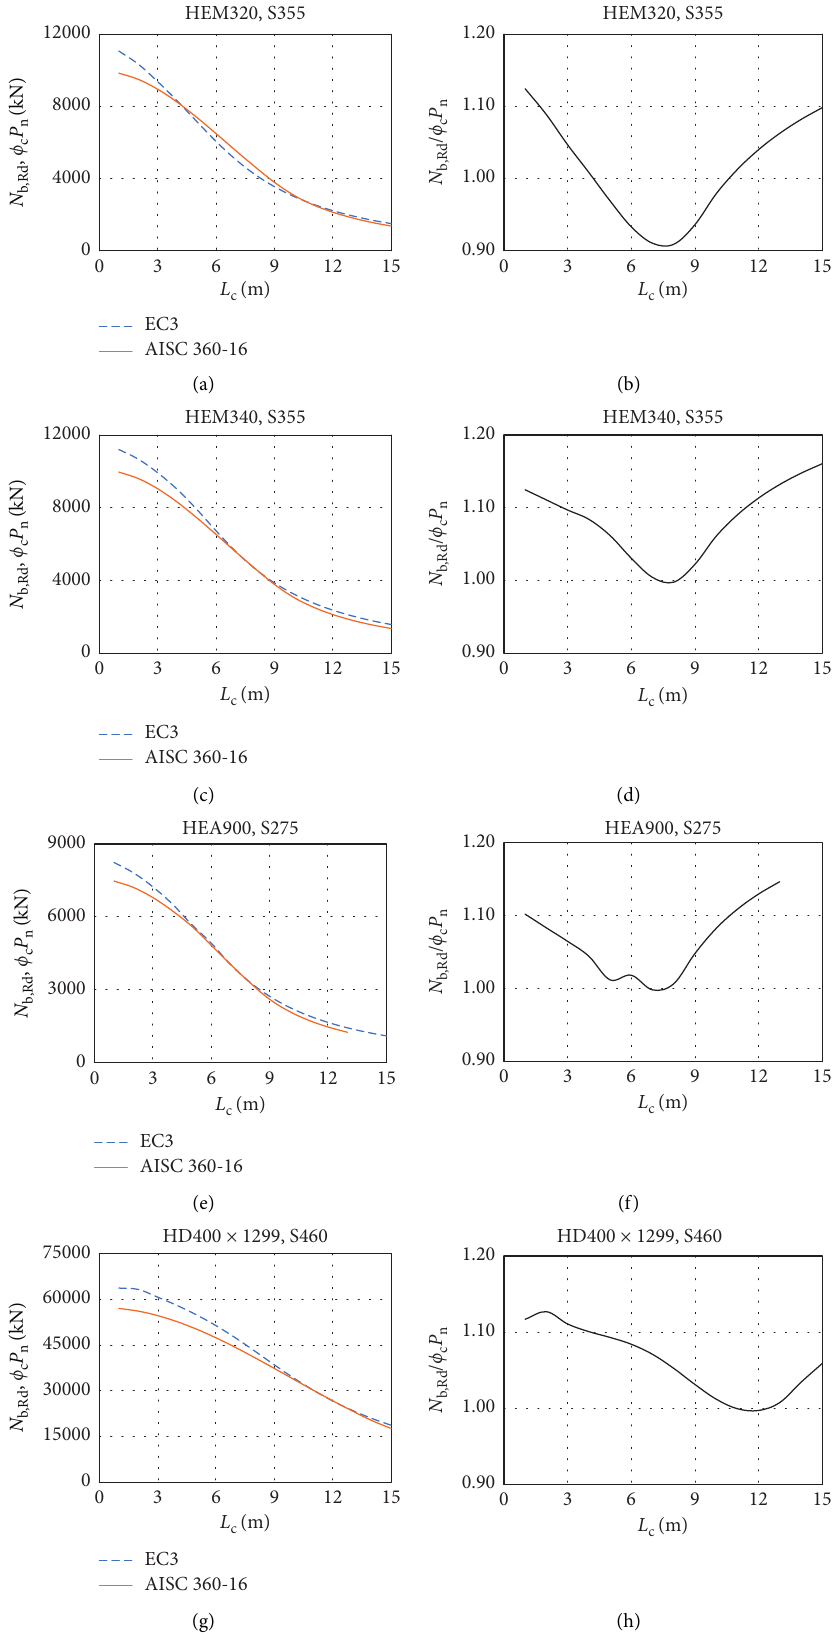
Figure 6: Variation of design compression capacities (design compressive strengths ( ϕ c P n ) for AISC 360-16 and design buckling resistances ( N b,Rd ) for EC3) with effective member length ( L c ) for some studied shapes and steel grades. The graphs in (a, c, e, g) compare the capacities, and the graphs in (b, d, f, h) plot the capacity ratios ( N b,Rd /ϕ c P n